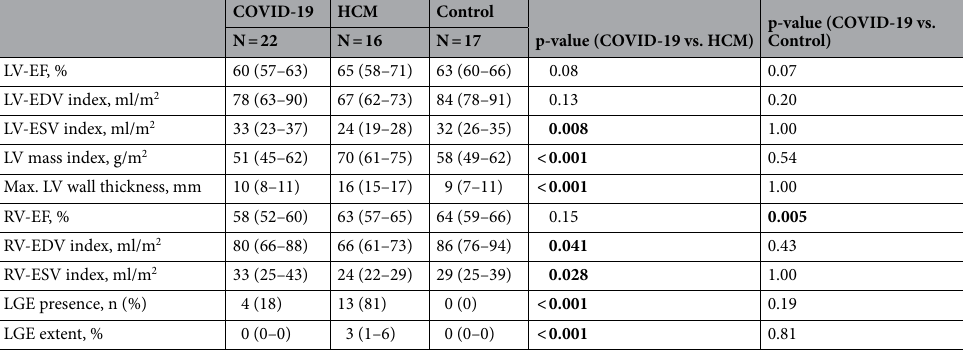
Table 2. Conventional CMR parameters. Bold values indicates p-value < 0.05.